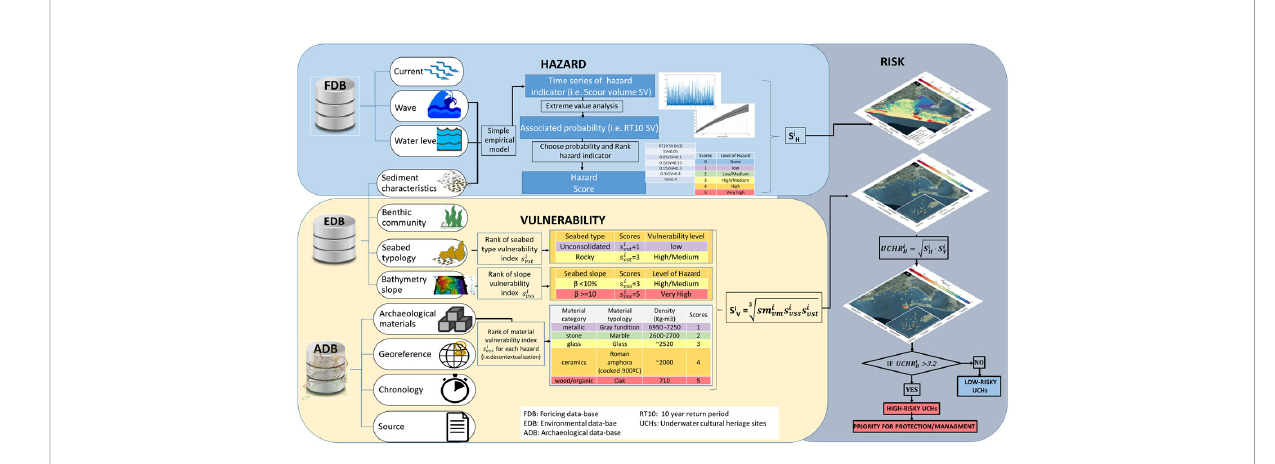
FIGURE 2 Work fl ow of the developed underwater cultural heritage risk assessment